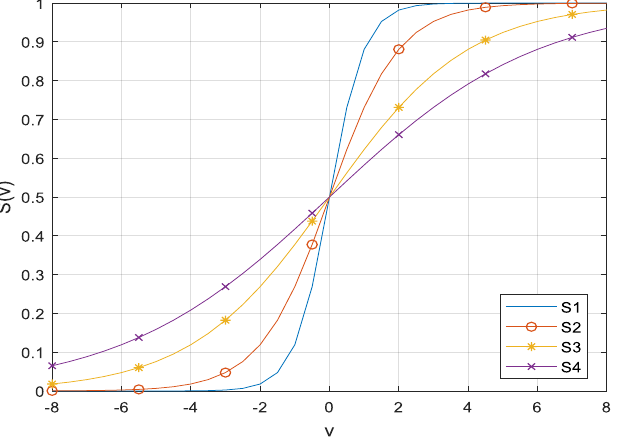
Computation 2019 , 7 , x FOR PEER REVIEW Figure 1. S-shaped transfer functions ( S1 – S4 ). Figure 1. S-shaped transfer functions ( S 1– S 4).